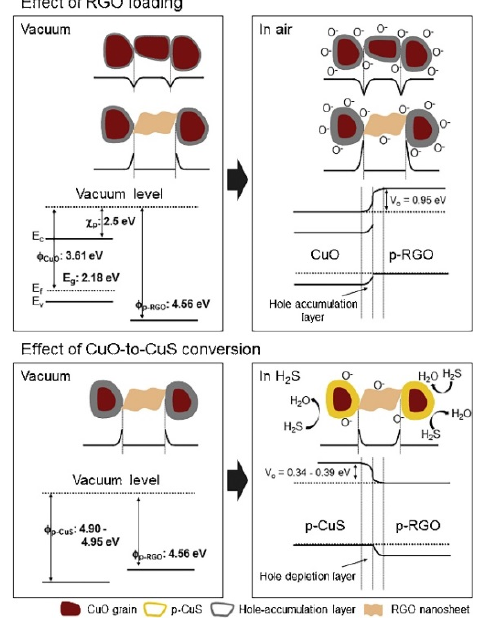
Figure 17. (upper part) Formation of rGO-CuO heterojunctions (lower part) conversion of CuO to CuS conversion[79]. CuS conversion